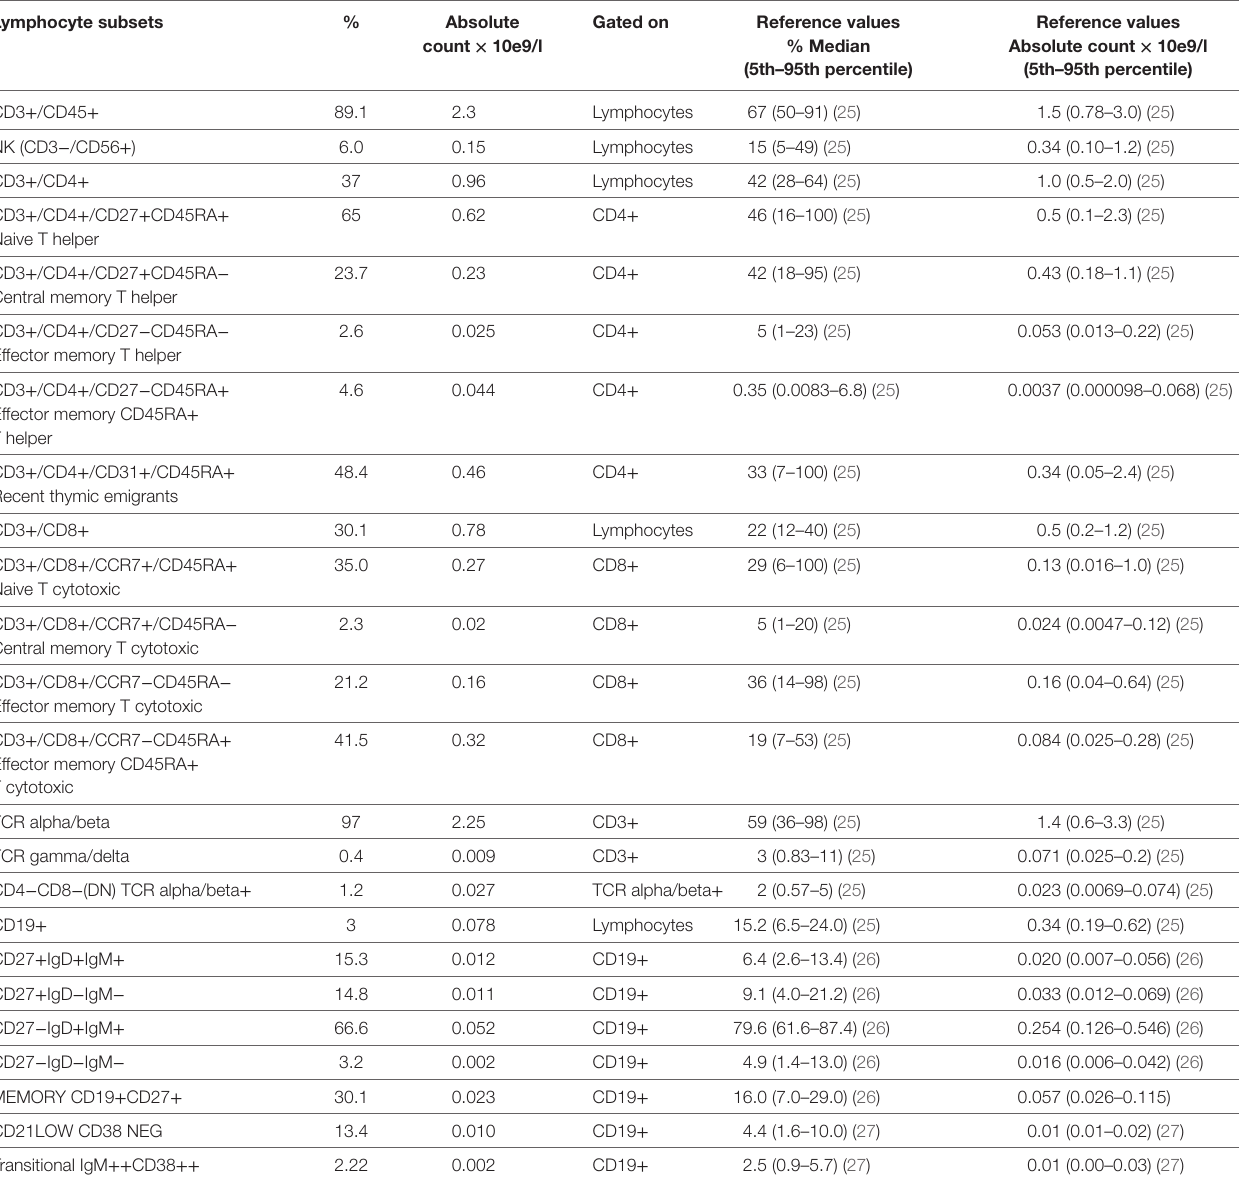
taBLe 1 | Immunophenotype analysis. Lymphocyte